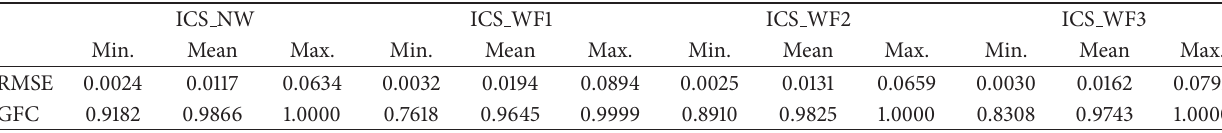
Table 4: Spectral representing accuracy comparison of the four ICSs with chips of Munsell and spectral image as training and testing sample,